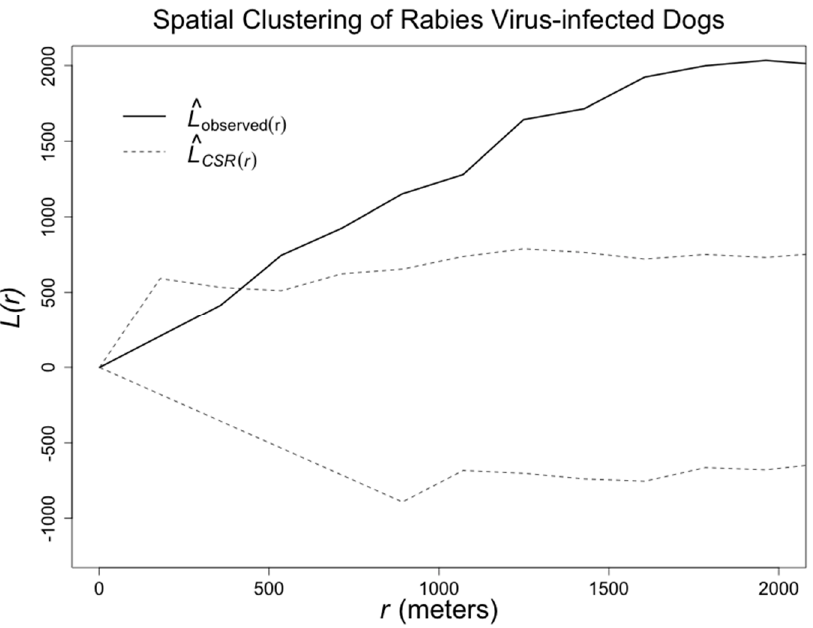
Figure 3. Strong clustering of rabid dogs evaluated with the L function. Envelopes (dashed lines) produced assuming complete spatial randomness (CSR).